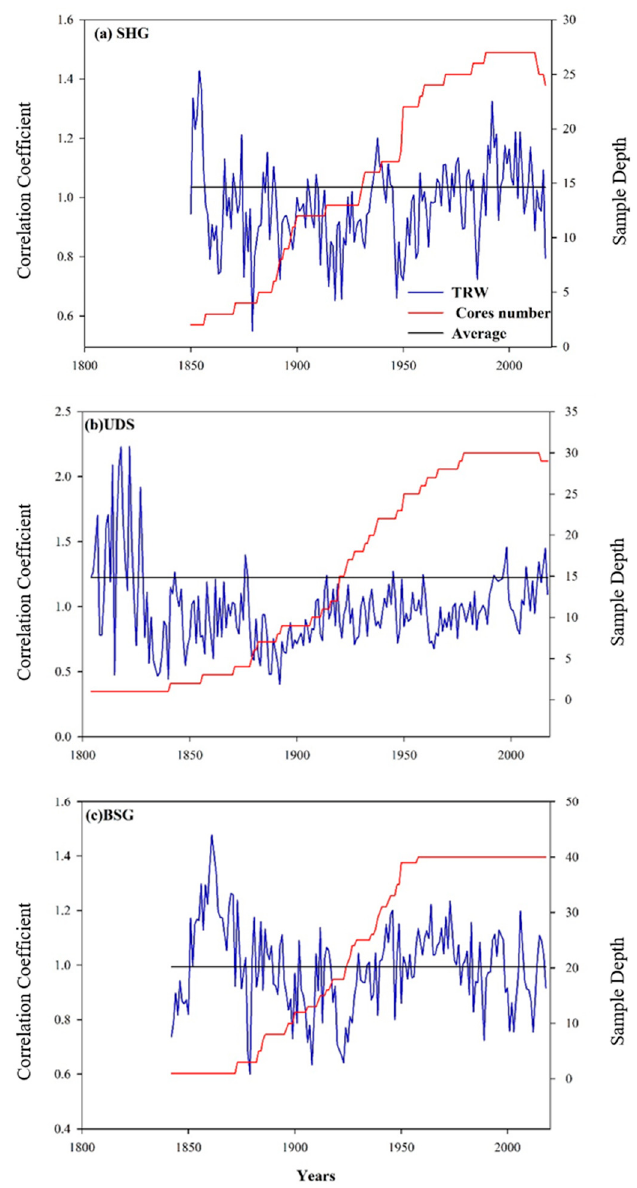
Figure 4. Standard tree ring chronologies of spruce ( a – c ) during the period 1800–2018 at SHG, UDS, and BSG in the northern area of Pakistan.